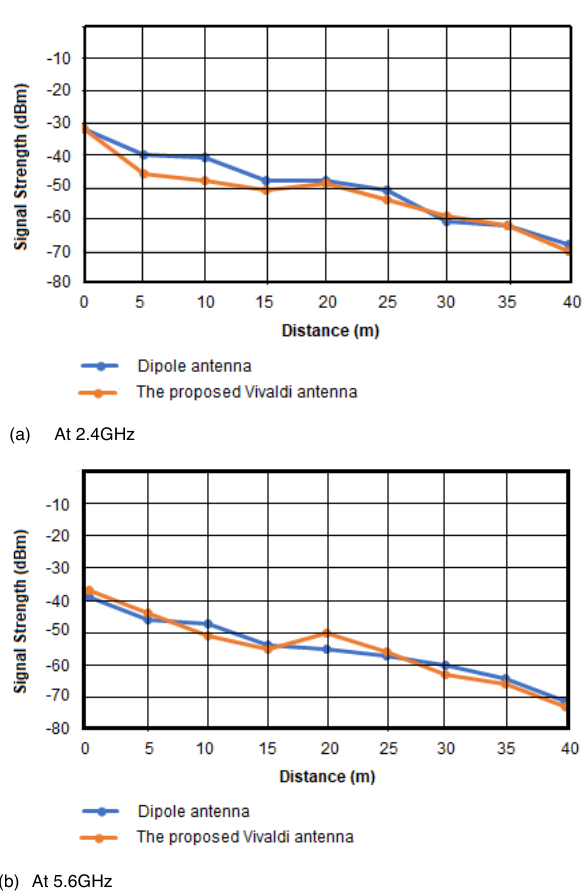
FIGURE 13. The signal strength comparison among dipole antenna and the proposed antenna with and without SIW structure in rainy